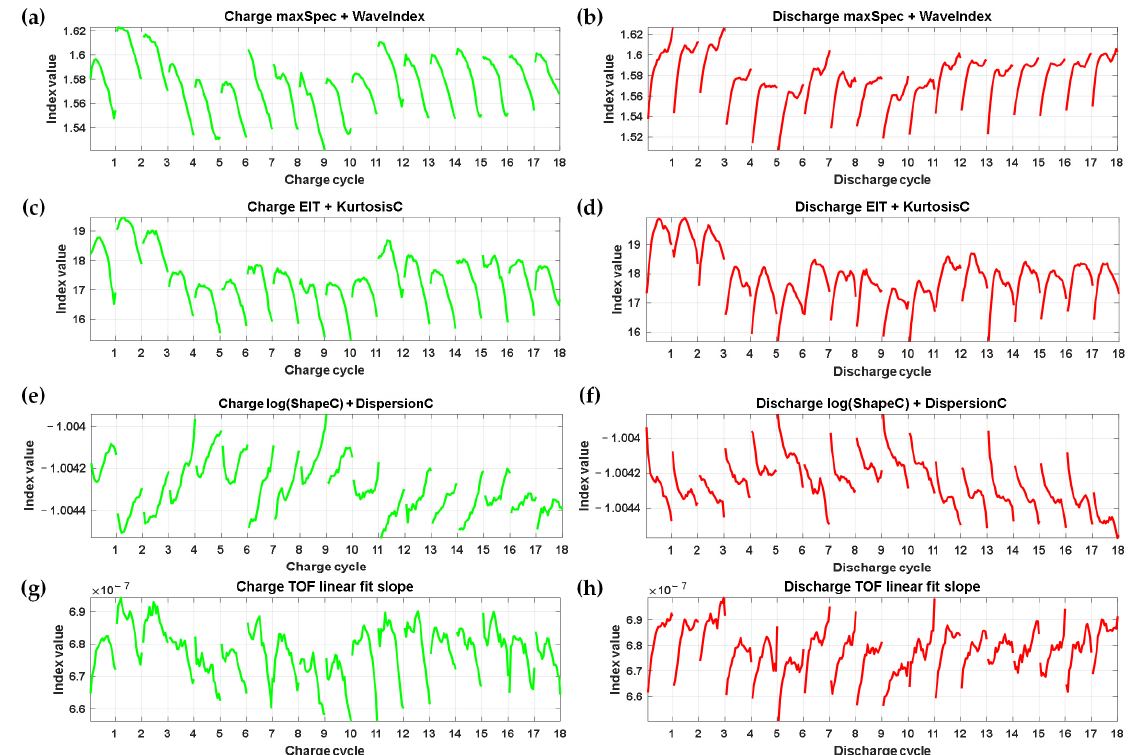
Figure 7. A diagram shows changes of characteristic parameters during the battery charge-dis- charge cycles. (( a ) means “spectrum peak + waveform index”, and the rest ( b – h ) are analogous. Note that “log(ShapeC)” means that take logarithm of the “point” parameter—“shape coefficient”, and then superimposed the “line” parameter on it.).